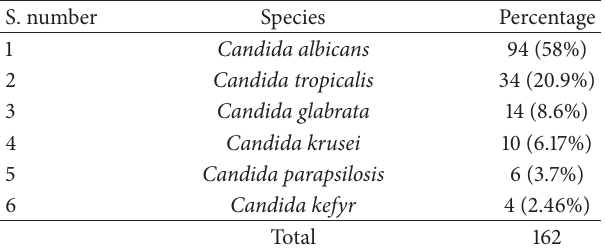
Table 4: Species-wise distribution of the isolates. S.